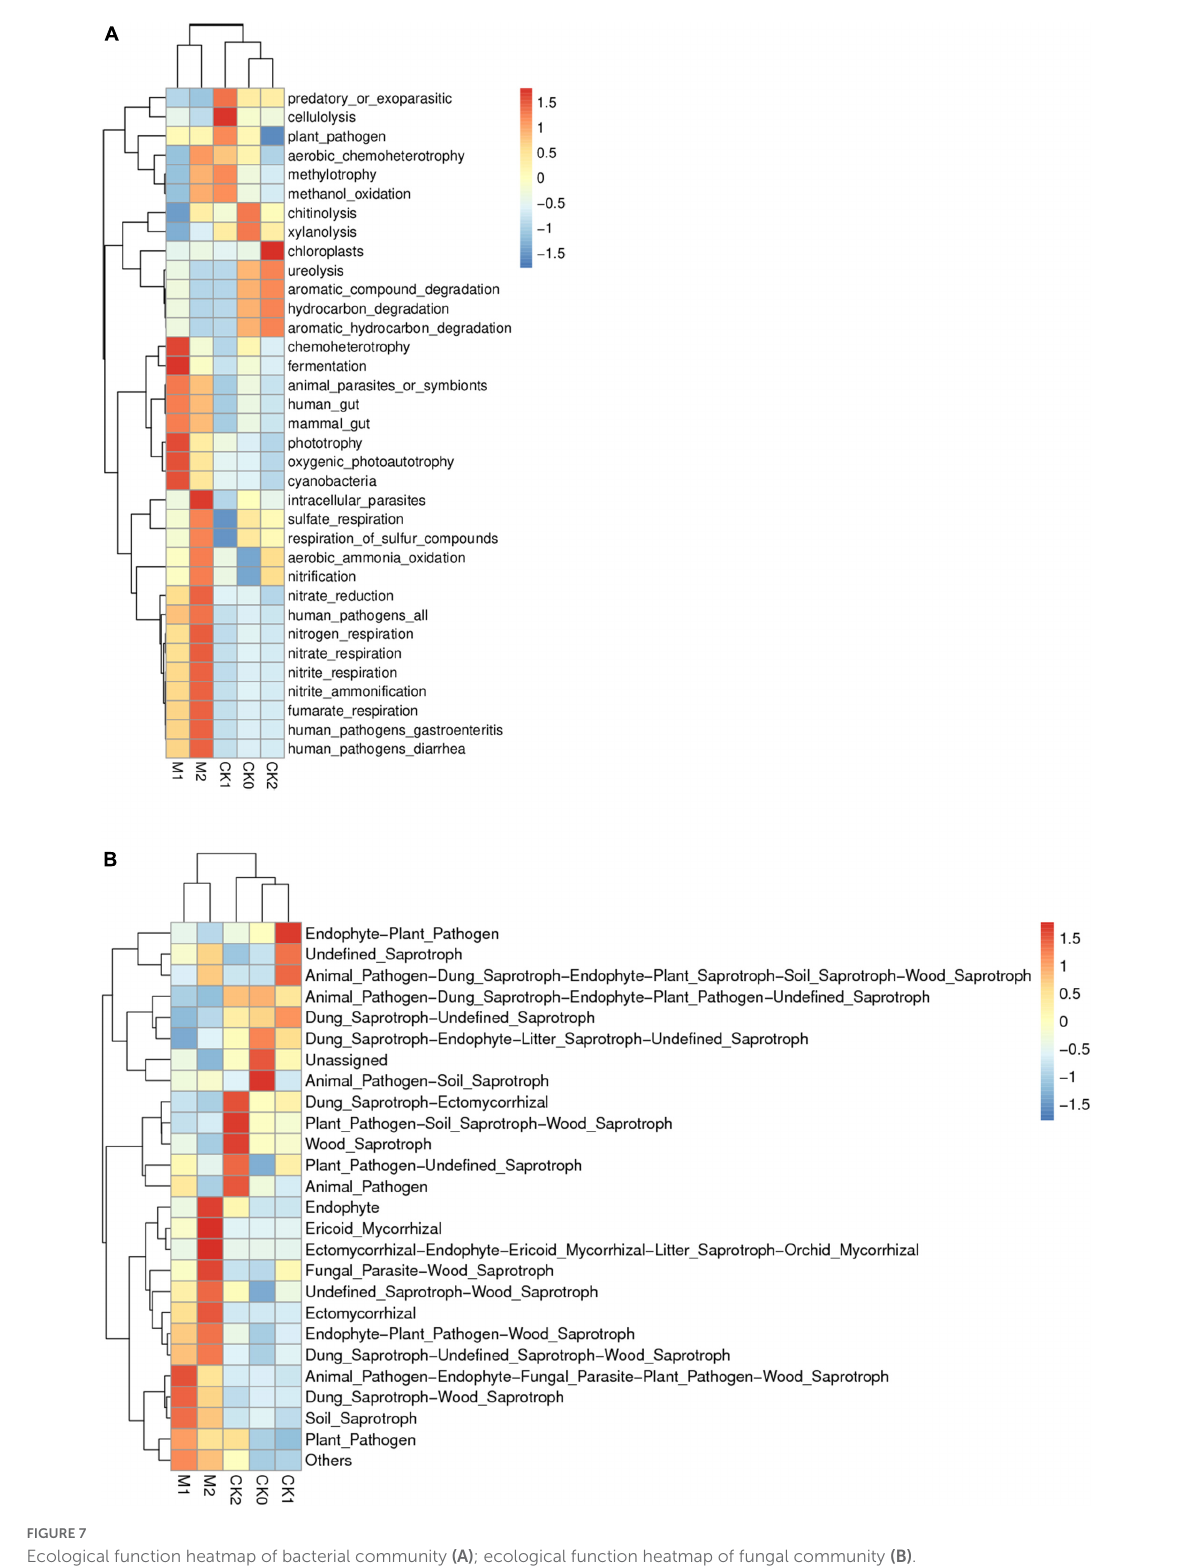
FIGURE7 Ecological function heatmap of bacterial community (A) ; ecological function heatmap of fungal community (B)